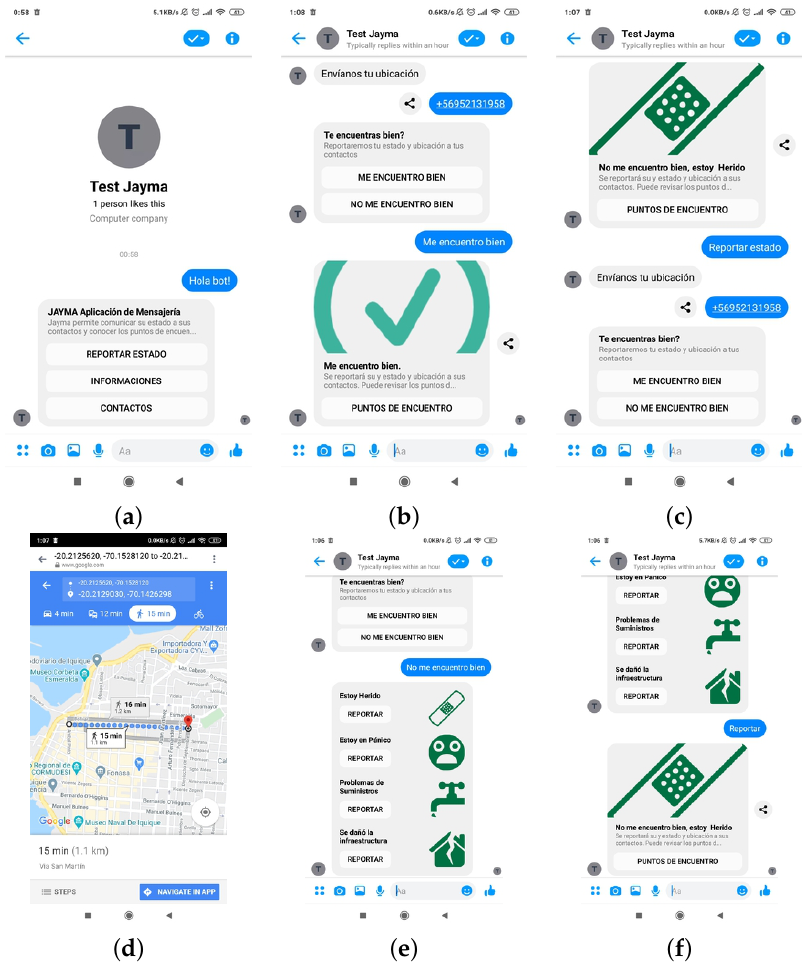
Figure 4. Screenshots of different tasks provided by the Jayma bot. ( a ) Main menu, ( b ) user status information, ( c ) meeting points, ( d ) evacuation route, ( e , f ) reports user